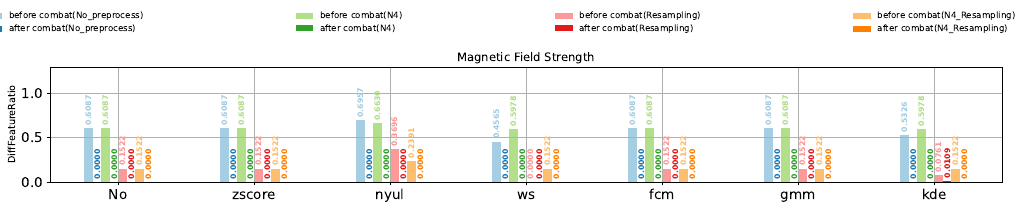
Figure 4. Impact of different preprocessing and harmonization methods for clinical patient data.